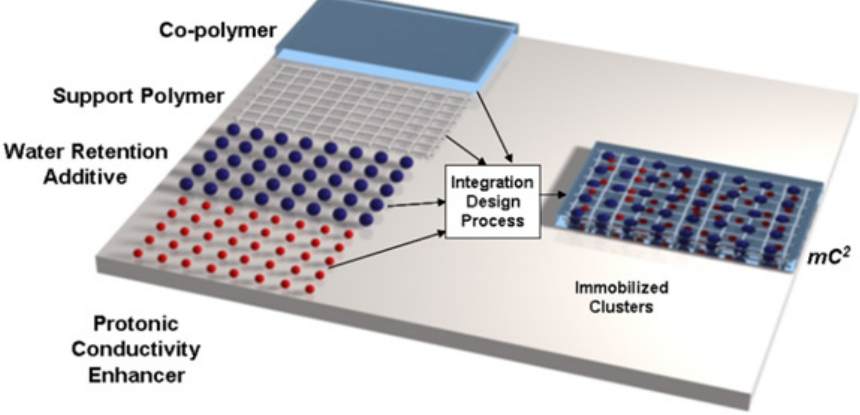
Figure 11. Schematic of the multi-component composite membrane (mC2) by FuelCell Energy [44].